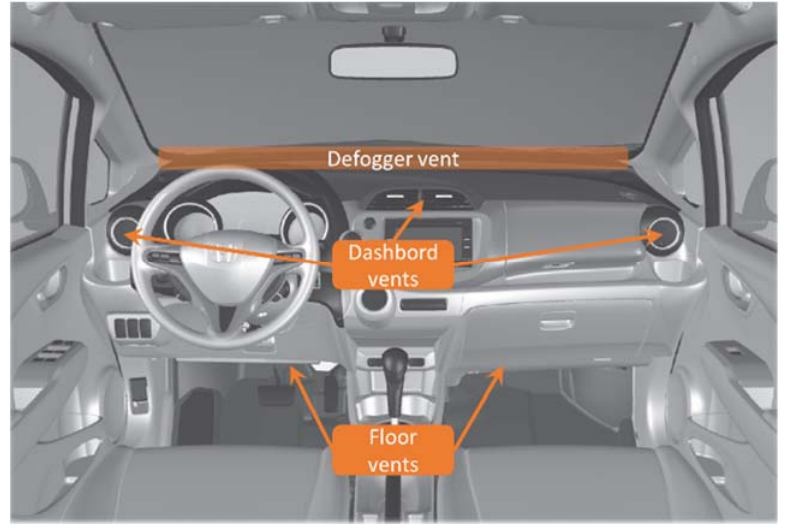
Figure 4. Air outlet locations [41]. Image ©Honda R&D Europe